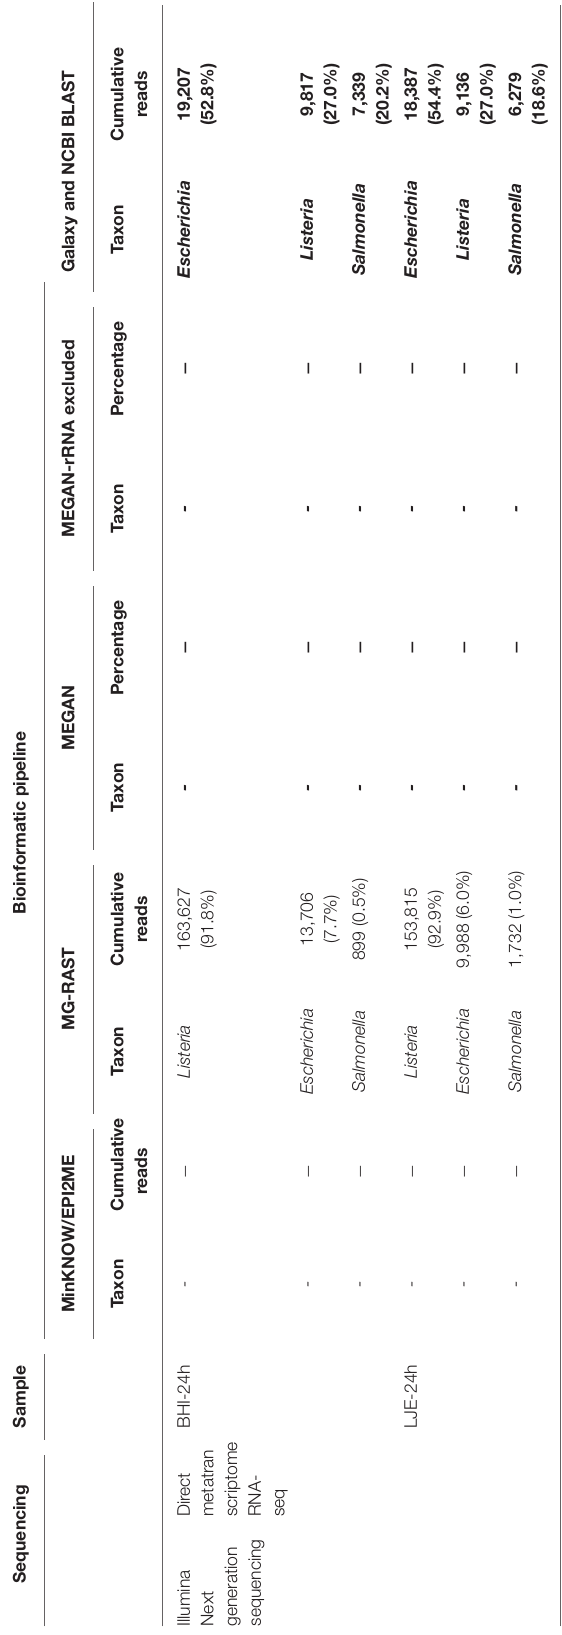
Supplementary Figure 3A . shows the verification of 24-h LJE cocktail culture, which was used in metatranscriptomic direct RNA-seq. The results showed the RT-PCR product of three expected bands for stx , invA and inlA in the 24-h cocktail culture, which confirms the presence of all three target pathogens. No bands appeared on negative controls using only PCR without the RT step, which indicates the absence of DNA contamination. Further validation was performed for the 4-h LJE cocktail culture sample, which was used in the multiplex RT-PCR amplicon sequencing. Supplementary Figure 3B . shows multiplex RT-PCR amplicon with three bands. The sizes of the amplicons are consistent with previous reports of 520 ( stx ), 244 ( invA ) and 153 ( inlA ) bp ( Supplementary Figure 3B line 2). No RT-PCR products were detected in the negative control (line 3, 4, and 5) using only PCR without the RT step, which indicates that there was no DNA contamination in the